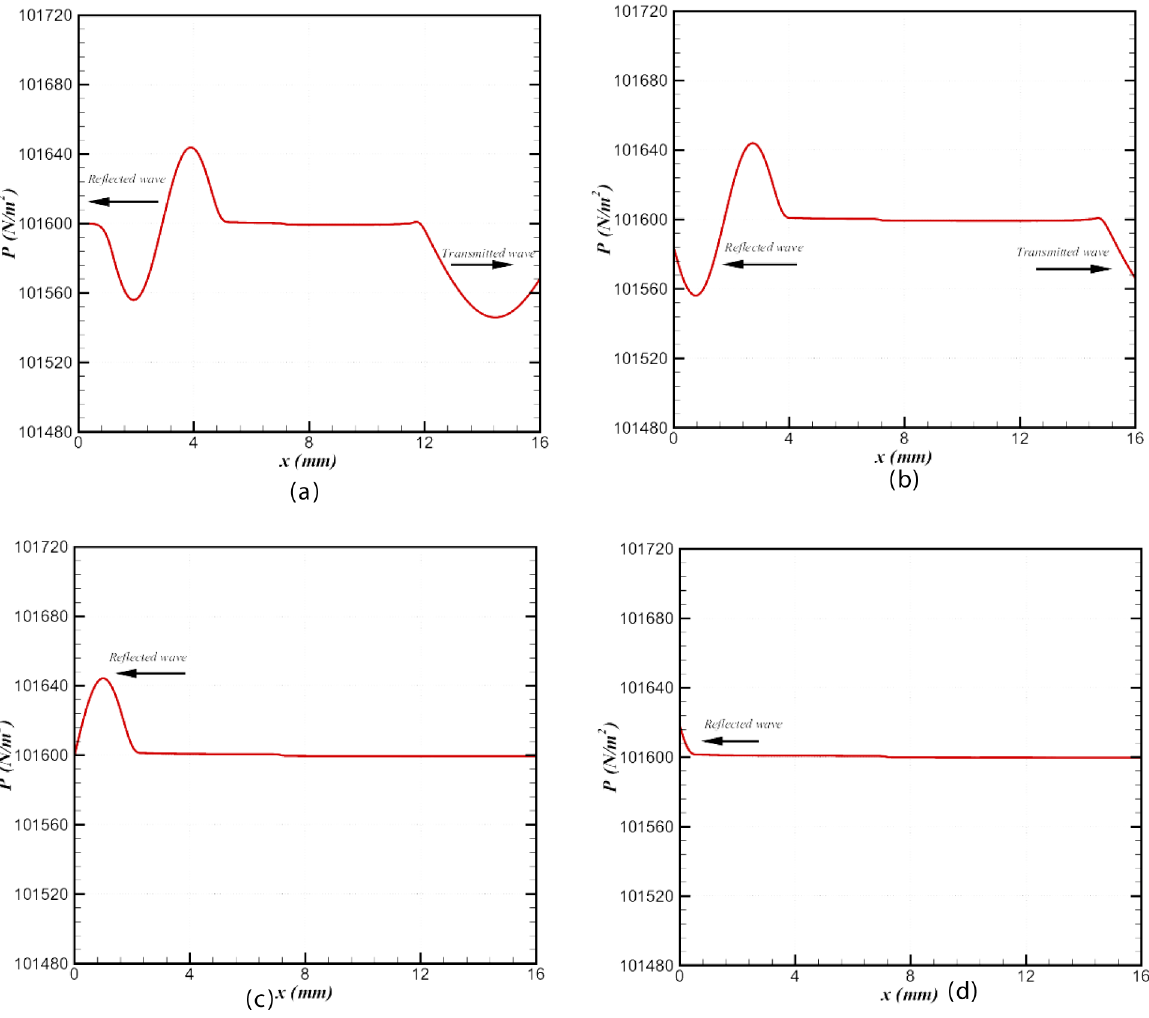
Figure 5. Snapshots of both waves at four different intervals: (a). 3 : 6 | 10 { 5 sec, (b). 4 | 10 { 5 sec, (c). 4 : 5 | 10 { 5 sec, and (d). 5 | 10 { 5 sec.